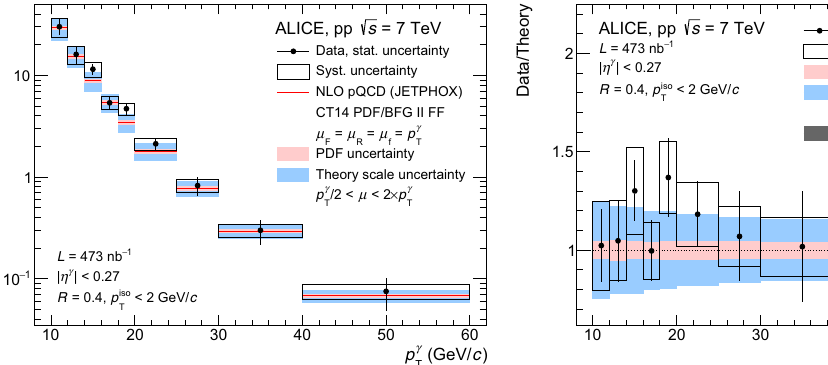
with JETPHOX. The normalisation uncertainty explained in the text (9.5%) is not included in the left panel and is presented as an overall box around unity in the right